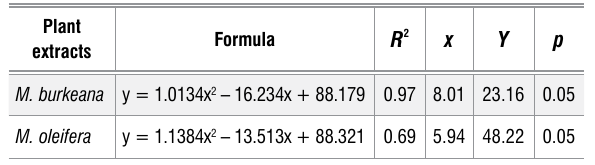
Effect of Monsonia burkeana and Moringa oleifera on mycelia growth suppression of Rhizoctonia solani in vitro Treatment (g/mL)